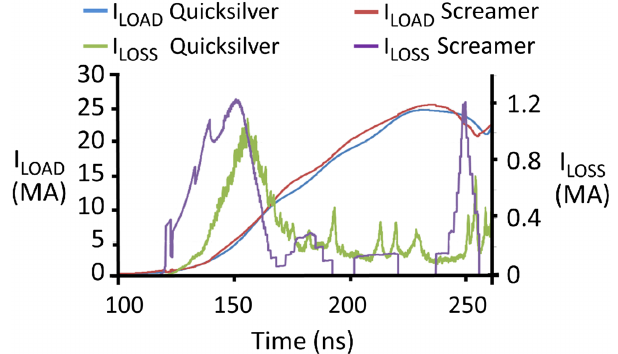
FIG. 17. Load current I and total electron loss current LOAD I at the beginning of the 5.3 nH initial load inductance for LOSS the Quicksilver and Screamer simulations of the CSMITL with the surrogate